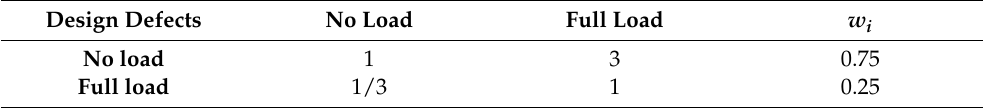
Table 20. Important judgment matrix for design defects under different operating conditions.